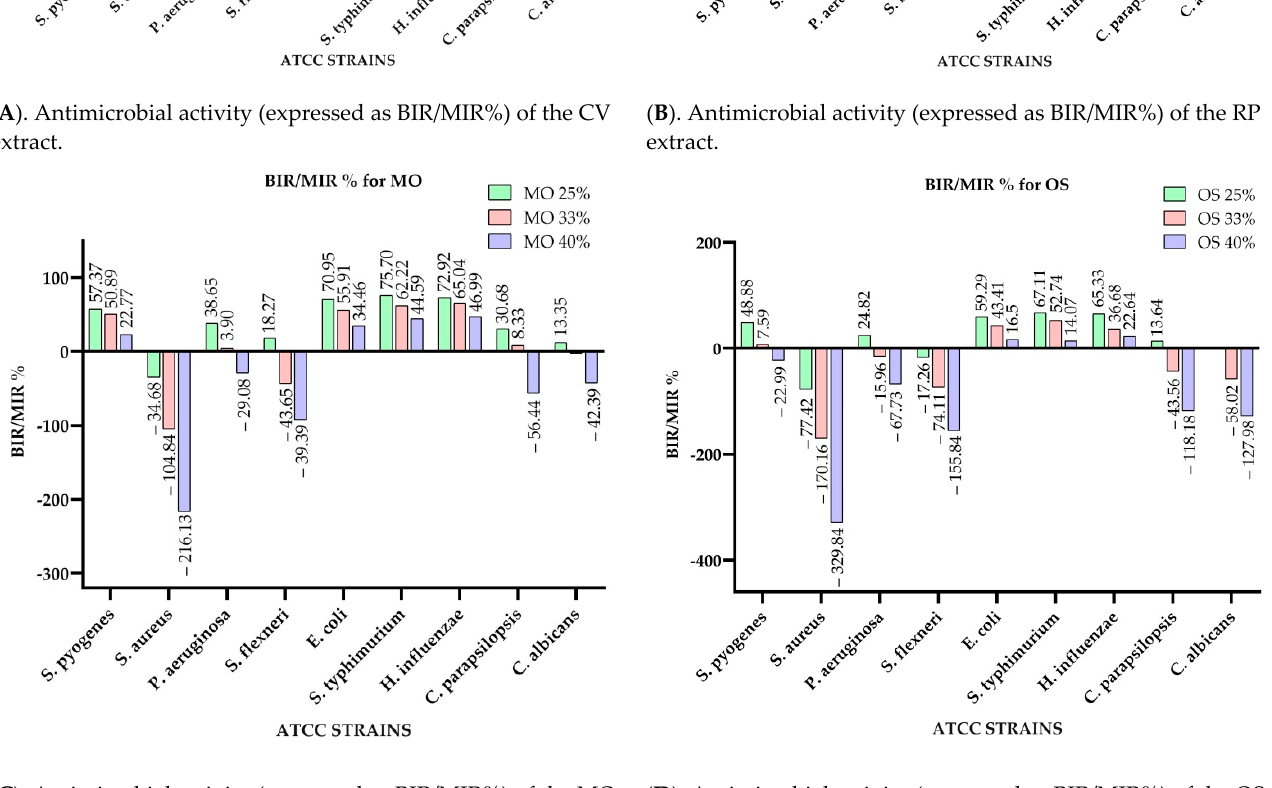
( A ). Antimicrobial activity (expressed as BIR/MIR%) of the CV extract.